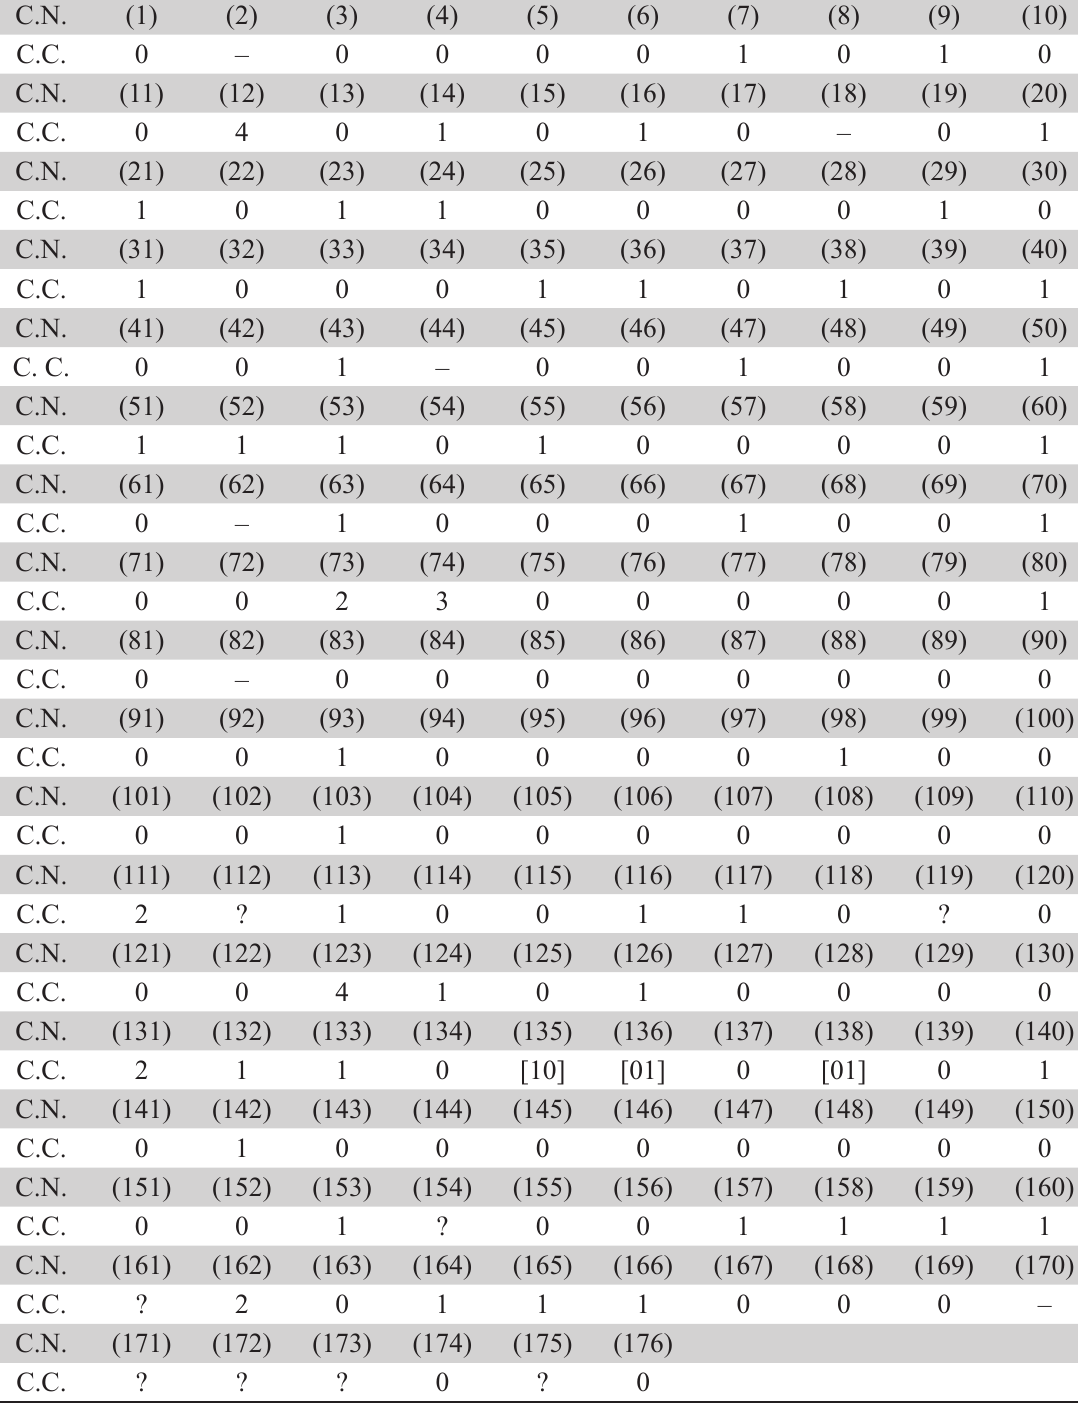
Table 1. Character coding for Xim trenzado gen. et sp. nov., according to the characters given by Miller & Hormiga (2004). Characters 135 (Femur I prolateral macrosetae), 136 (Tibia I proximal dorsal macroseta) and 138 (Tibia II proximal dorsal macroseta) were coded as polymorphic (among brackets) because they differed for each sex. Abbreviations: character coding = C.C.; character number = C.N.